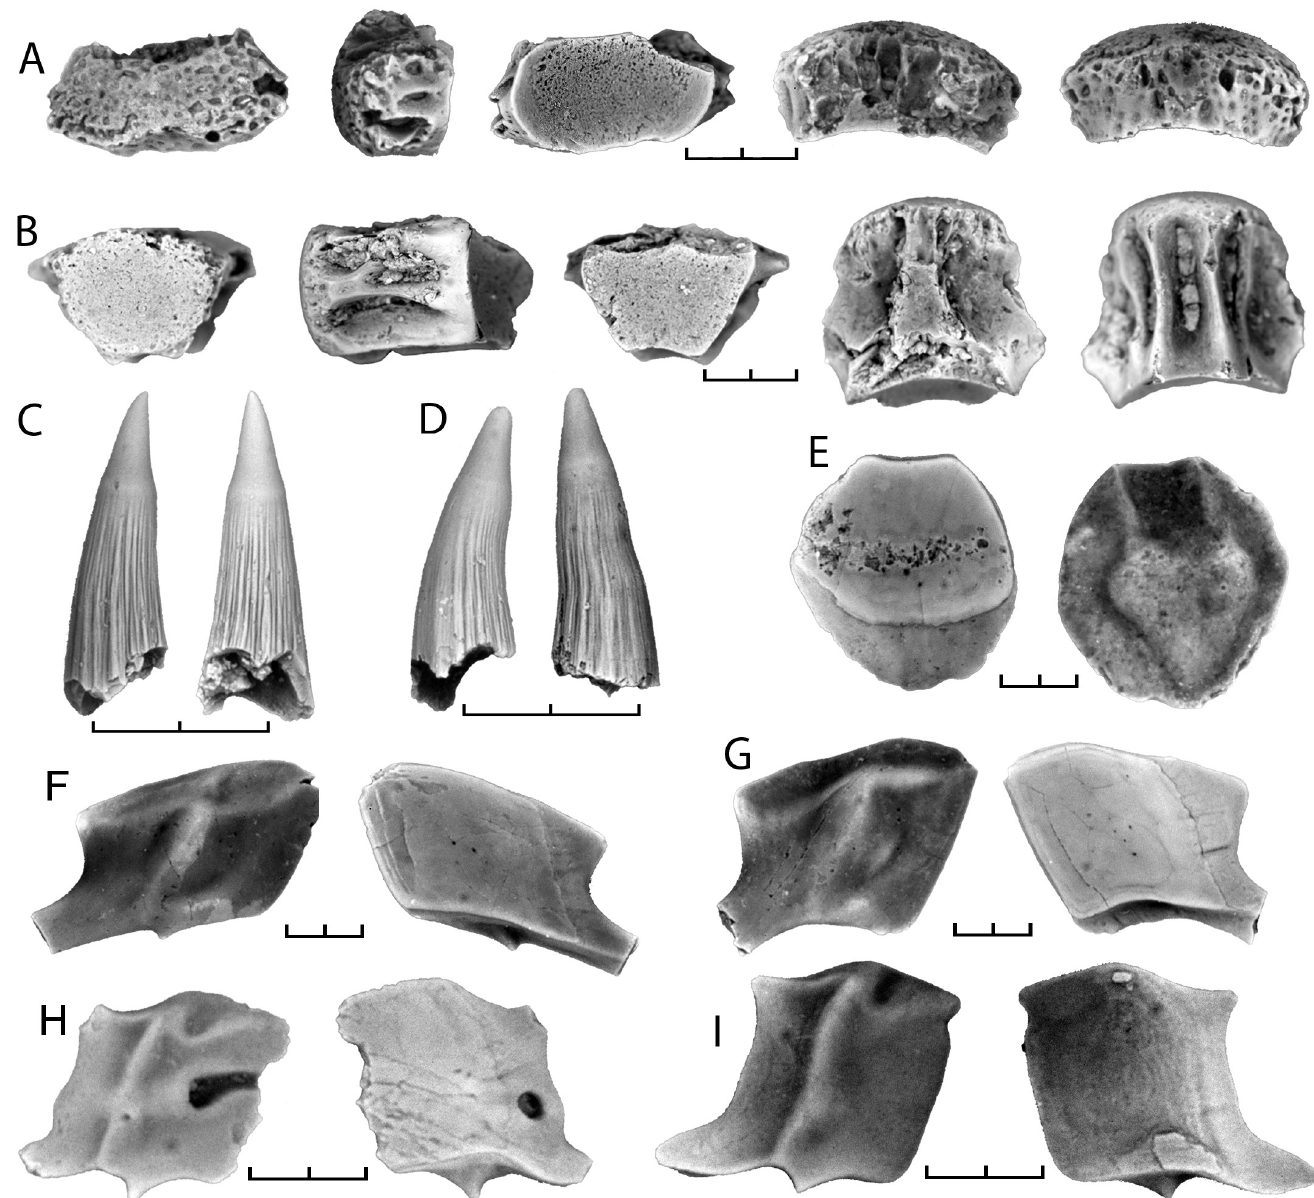
Figure 4. Lepisosteidae elements from the Milk River Formation. A) first centrum of the vertebral column, specimen TMP 2000.2.28. B) mid-dorsal centrum, specimen UALVP48859, from UALVP locality MR6, Verdigris Coulee, Alberta. C ,